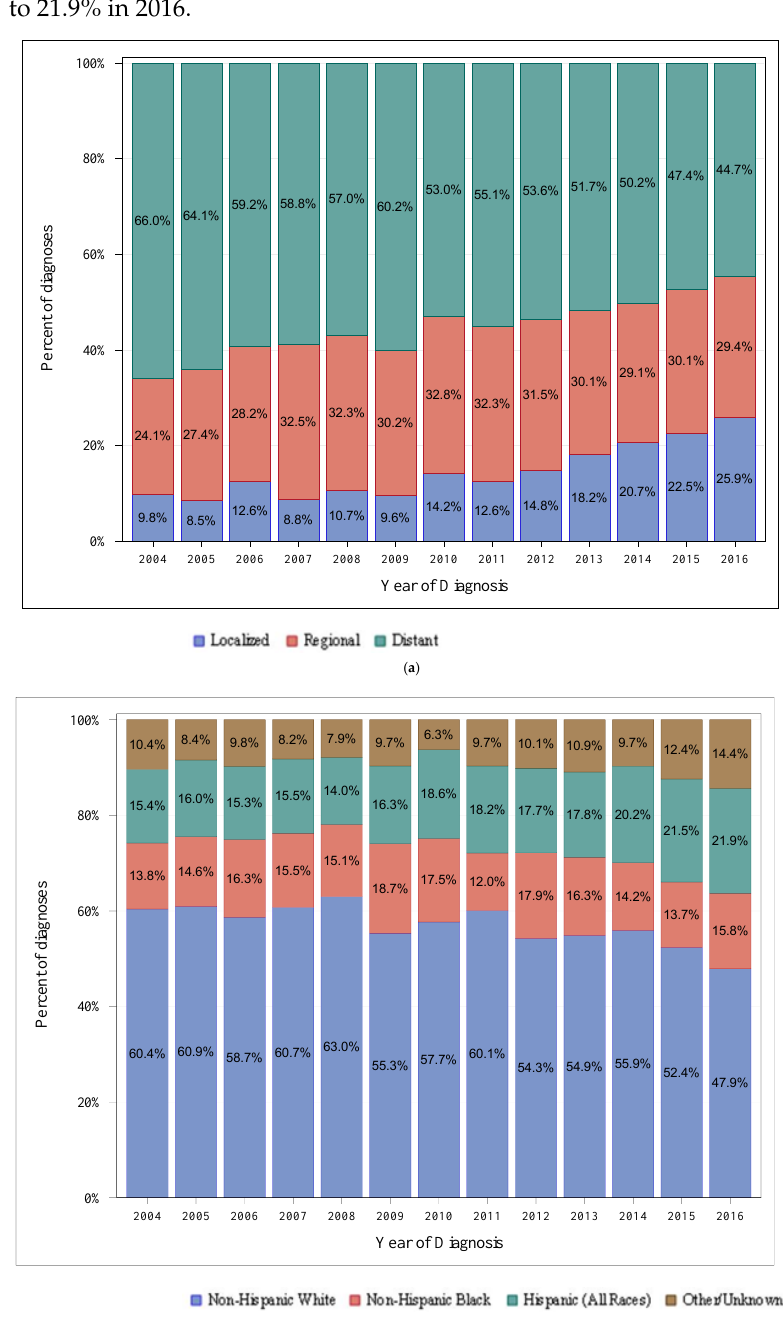
Figure 2. ( a ) Differences in Stages at Presentation from 2004 – 2016 in SEER, Ages < 50. ( b ) Differences in Race/Ethnicity from 2004 – 2016 in SEER 18, Ages < 50.